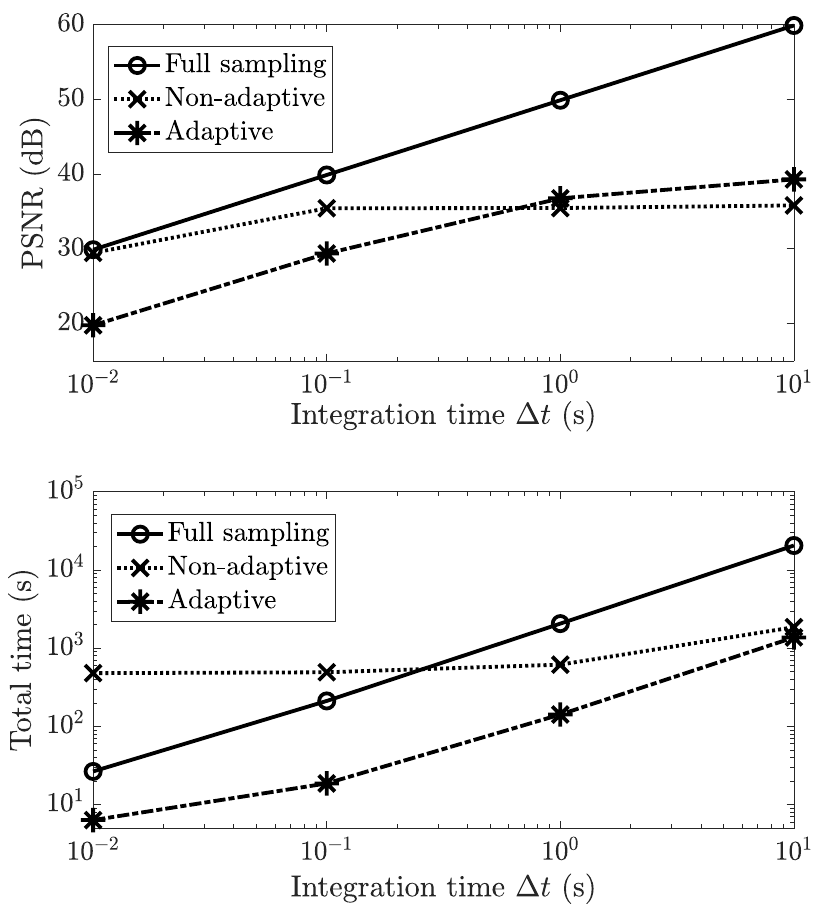
Figure 7. The effect of the integration time ∆ t on the U2OS cell scene’s reconstruction PSNR and total time (acquisition + reconstruction) for multitrack full sampling, multitrack non-adaptive CS and multitrack adaptive CS. α = 0 and max ( X ) = 5 × 10 4 photons s − 1 voxel − 1 are